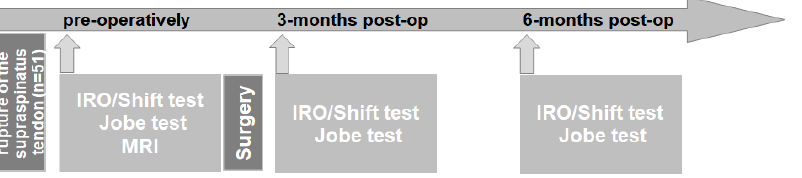
Figure 1. Prospective, blinded study design.